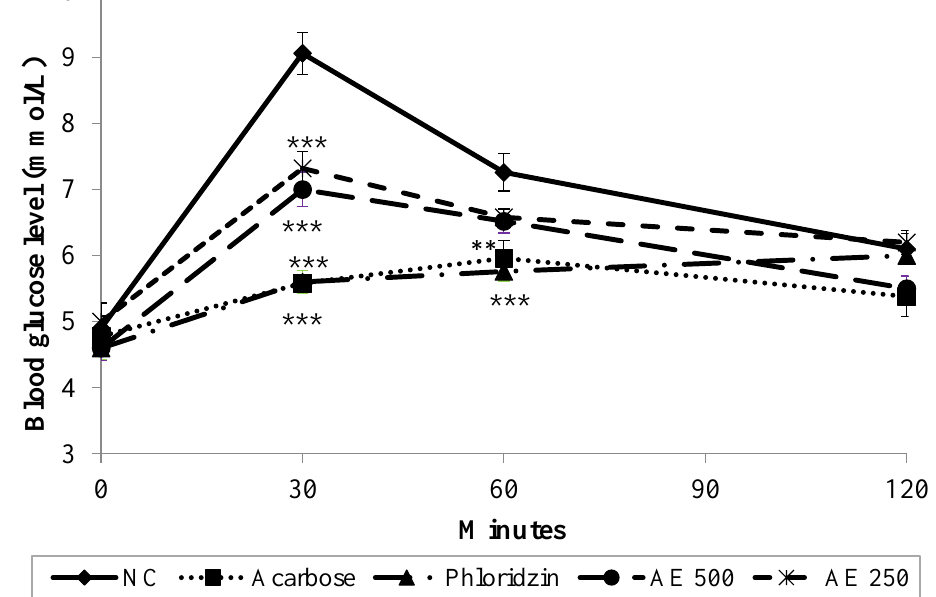
Figure 3. Effect of normal control (NC), acarbose, phloridzin and aqueous extract (AE) of NPV on postprandial blood glucose levels in oral sucrose tolerance test. Data is expressed as means ± S.E.M. ( n = 6). * p < 0.05, ** p < 0.01, and *** p < 0.001 vs. the NC group.